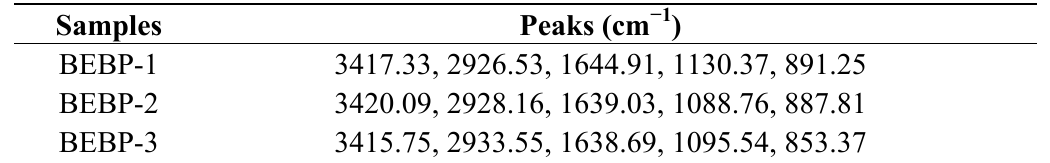
Table 1. FT-IR spectra of the polysaccharide